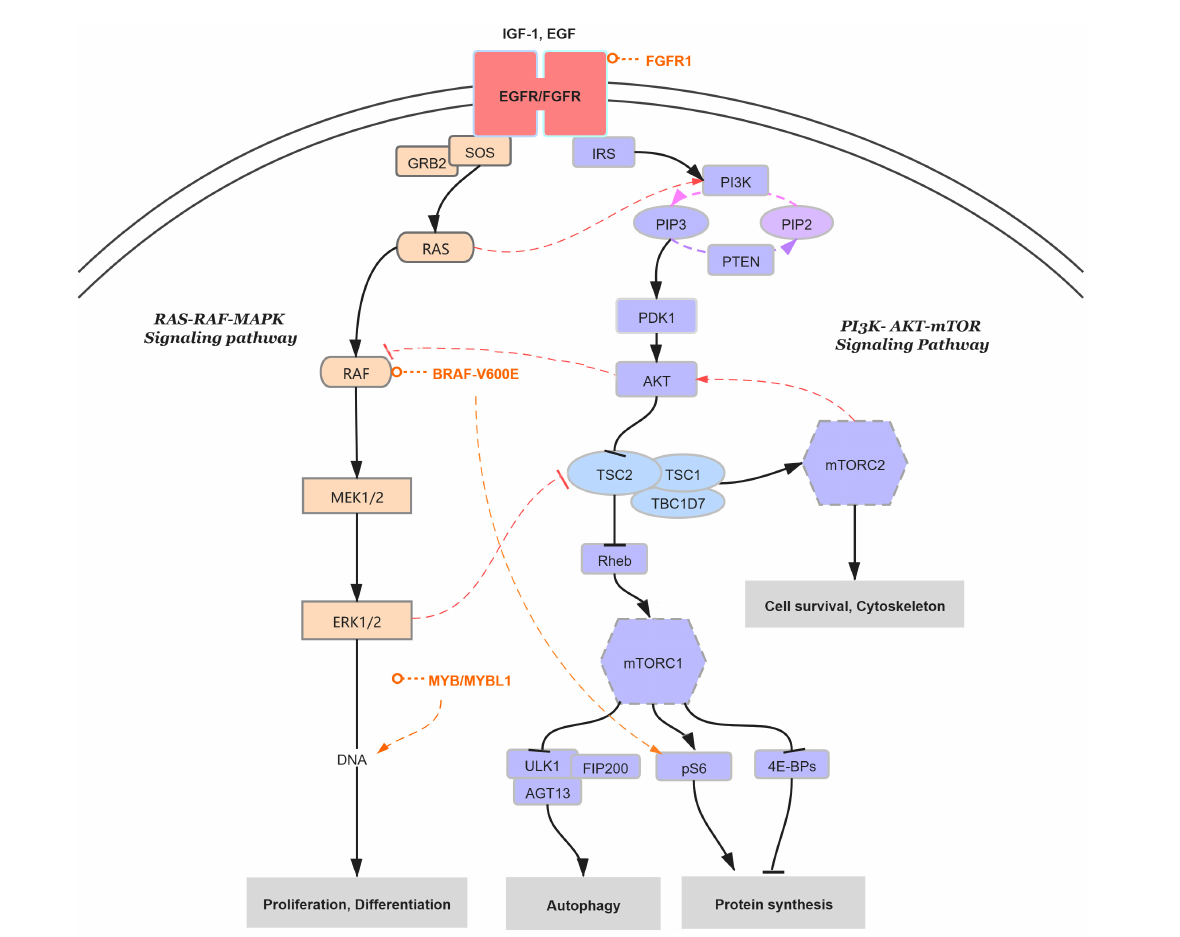
FIGURE1 RAS-RAF-MAPK signaling pathway with molecular genetic alterations affected in LEATs. Genetic alterations detected in LEAT entities mainly involve two signaling cascades, namely, RAS-RAF-MAPK (left/pink) and PI3K-AKT-mTOR (right/blue). Signals begin at the insulin-like growth factor-1 (IGF-1) receptor at the cell surface, as well as the epidermal growth factor (EGF) receptor, and transmit to the downstream canonical cascades of the MAPK pathway (through RAS, RAF, and MEK1/2 to ERK1/2) and the mTOR pathway (through PI3K, PDK-1, AKT, and TSC1-TSC2-TBC1D7 complex to mTORC1/2). The specific genetic alterations are listed in the figure (light red), including the FGFR1 alteration and BRAF V600E mutation detected in GG and DNET and the MYB/MYBL1 fusions found in AG and IDG, with the activation of the RAS-RAF-MAPK signaling pathway to control DNA transcriptions for cell proliferation and differentiation. In particular, the MAPK pathway activation is regulated by substrates of the PI3K-AKT-mTOR signaling cascade, which, in turn, was controlled by the components from RAS-RAF-MAPK cascades to determine the protein synthesis (dashed